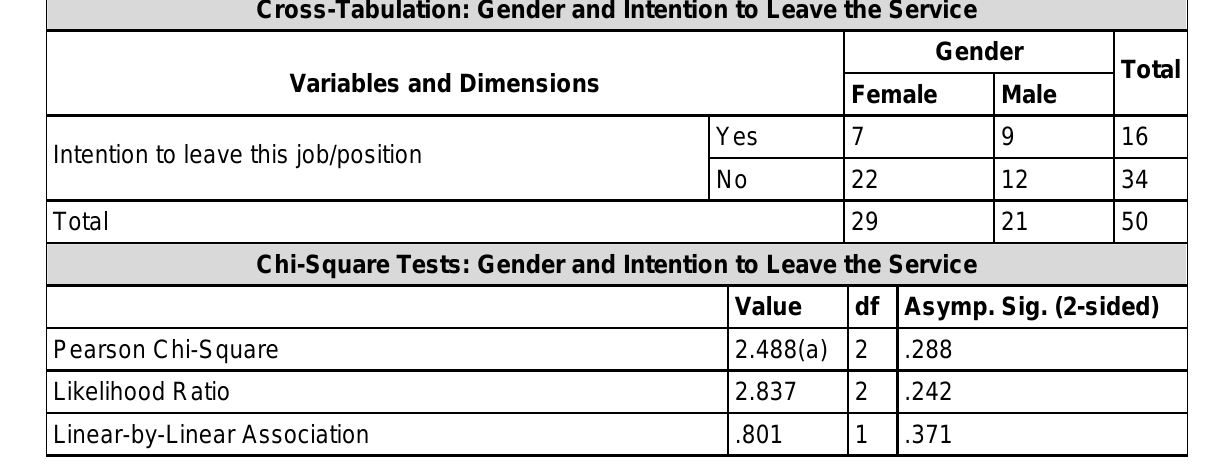
Table 5: Gender and intention to leave the service Cross-Tabulation: Gender and Intention to Leave the